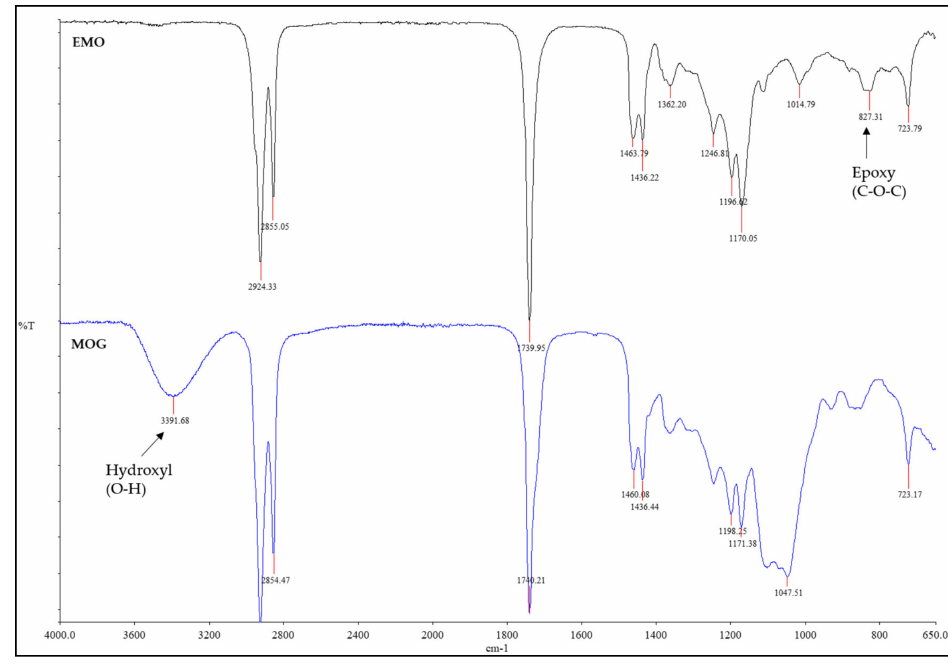
Figure 8. FTIR spectra for epoxidised methyl oleate (EMO) and MOG-polyol.